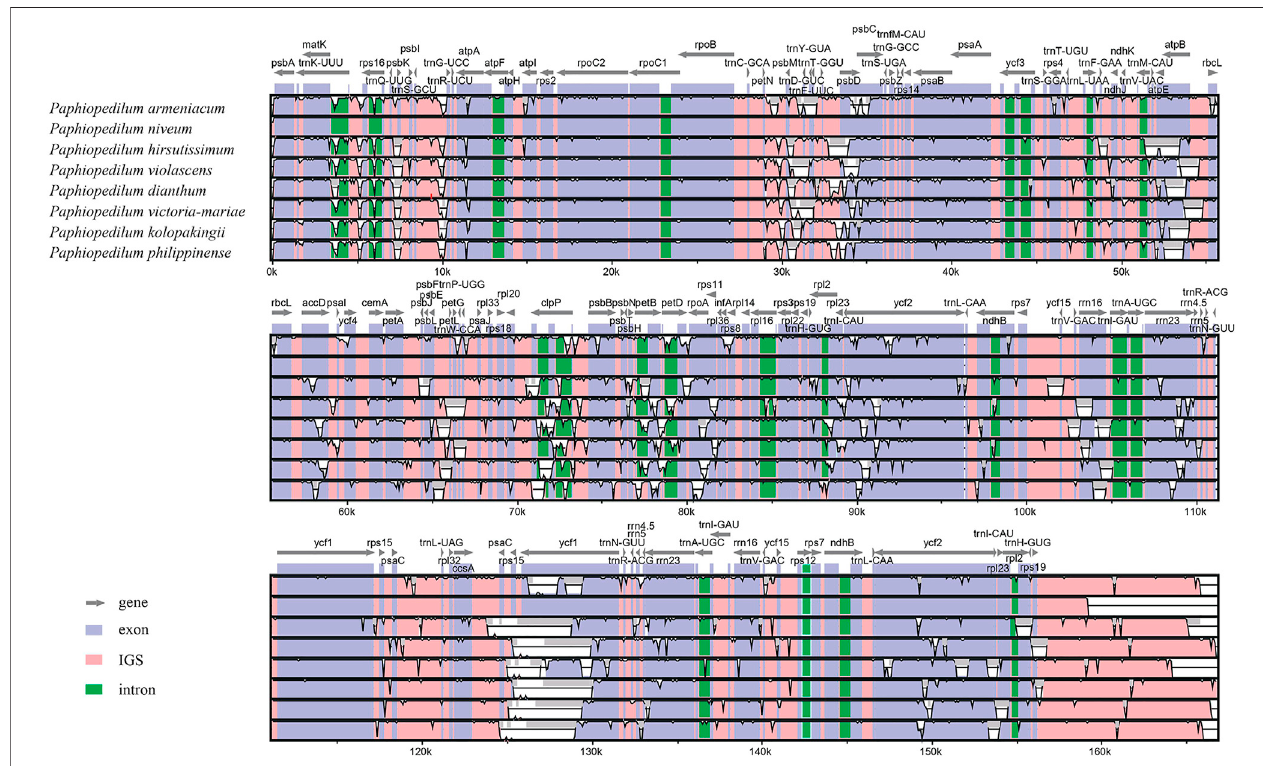
FIGURE5| Comparisonofnine Paphiopedilum chloroplastgenomesusing P.tranlienianum asareferencesequencewitha50%identitycutoff.Grayarrowsshow the position and direction of each gene. The colored areas indicate the exon, intron, and intergenic spacer (IGS) sequences. The vertical axis indicates the sequence identity, ranging from 50% to